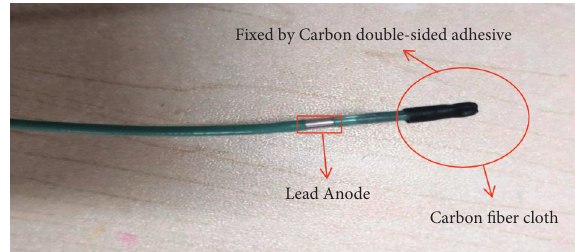
Figure 4: Carbon fiber cloth-modified TTCP